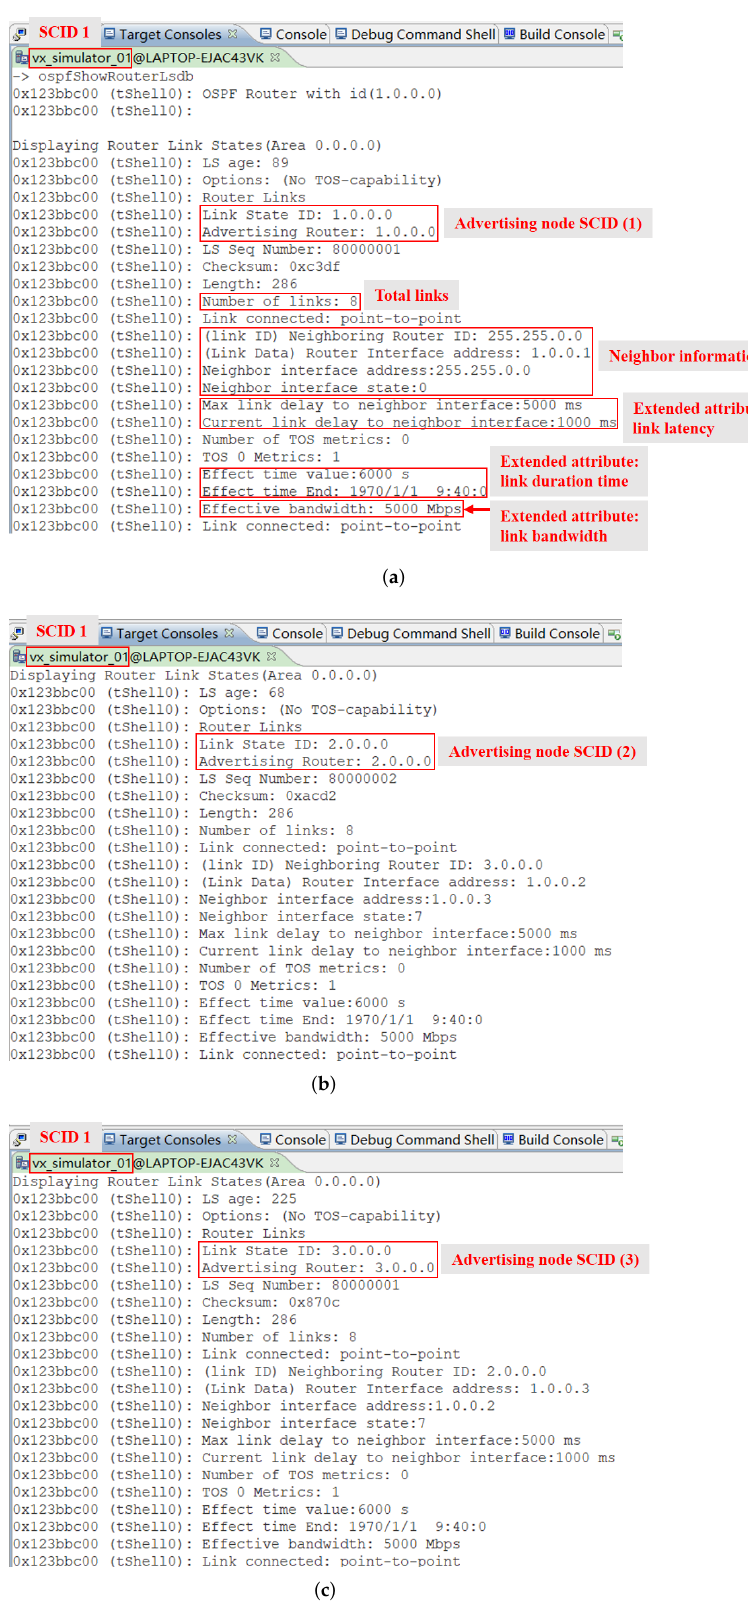
Figure 19. The link-state database of the optimized OSPF in node vx_simulator_01 (SCID 1). ( a ) The router link states of node vx_simulator_01 (SCID 1). ( b ) The router link states of node vx_simulator_02 (SCID 2). ( c ) The router link states of node vx_simulator_03 (SCID